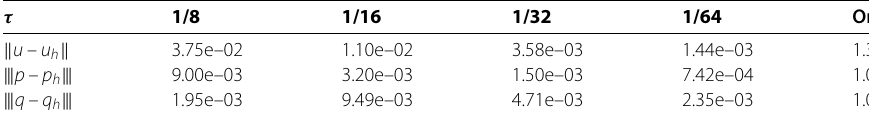
Figure 1 The sketch of Example 1 about errors and degrees of freedom with β = 2